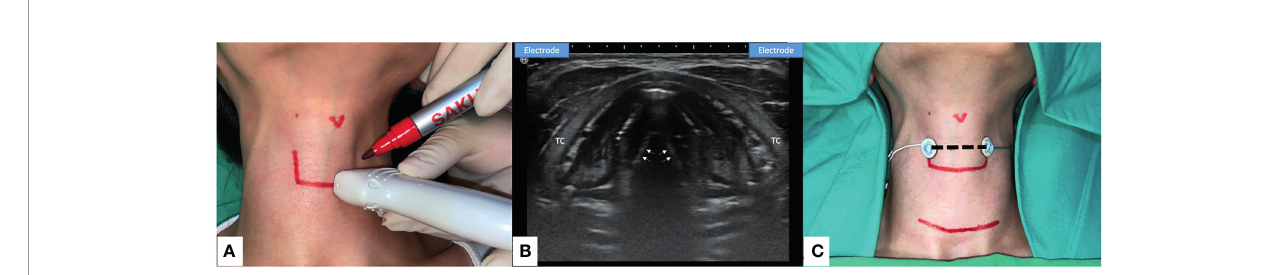
FIGURE 3 | Transcutaneous Anterior Laryngeal Recording electrode placement for Intraoperative neural monitoring. (A) Preoperative skin marking: lateral border of thyroid cartilage and the level of true vocal fold. Precise localization may be done with the application of ultrasound (US). (B) The axial view of true vocal folds (white arrow). Lateral side of the thyroid cartilage (TC) lamina is the optimal location to place the skin surface electrodes (US illustration). (C) Transcutaneous recording electrodes are placed at the level of true vocal fold (dotted line). Transcutaneous recording method is applicable in small incision wound or remote thyroid surgery. Skin fl ap beneath the surface electrodes should be avoided.